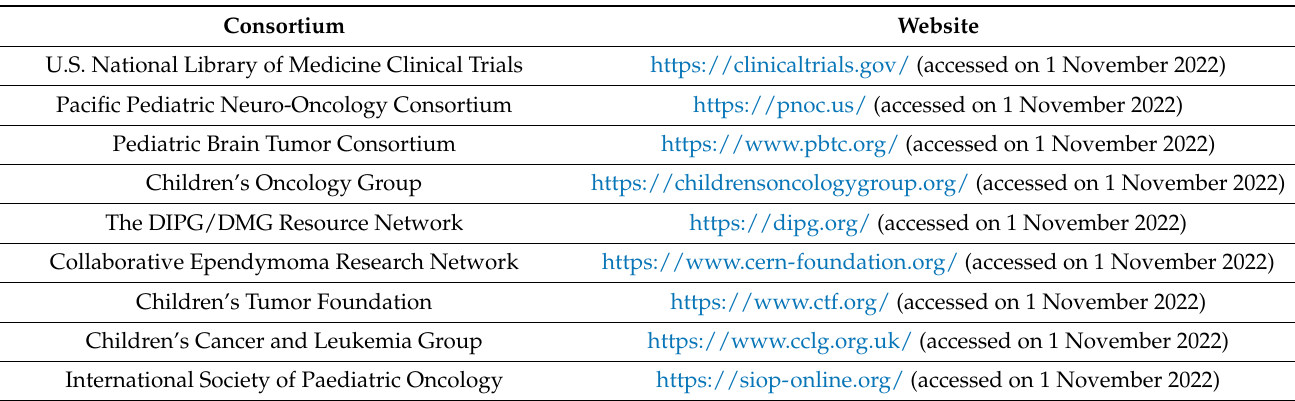
Table 1. Pediatric Cancer Therapy